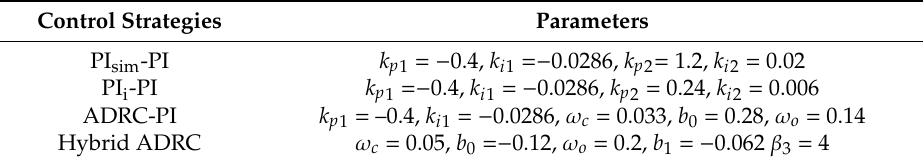
Table 4. Parameters of di ff erent control strategies for SST system in the